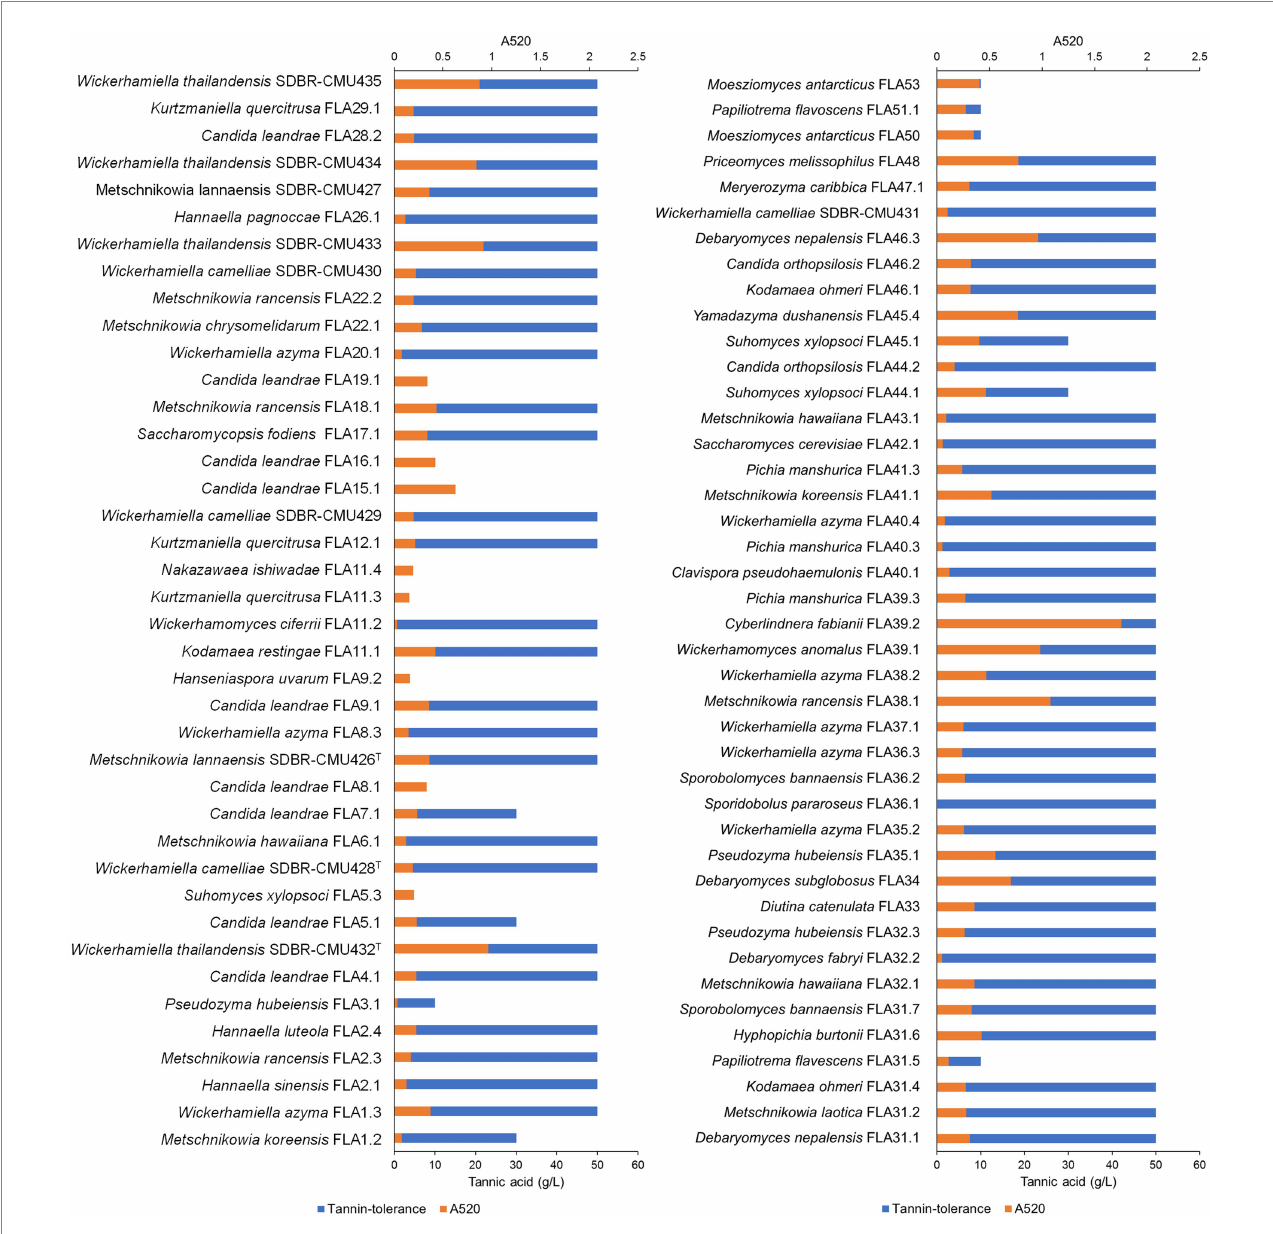
FIGURE 8 Tannin-tolerant test and tannase activity detection of all yeast strains using the visual reading method. An absorbance value of higher than 0.5, was considered a positive indication of tannase